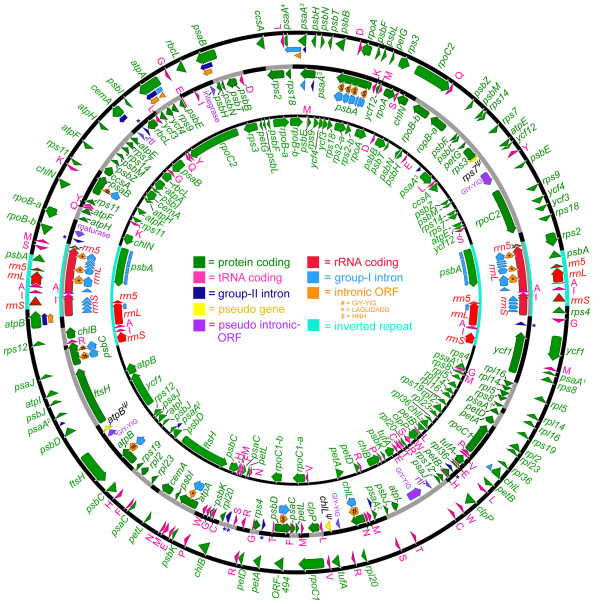
Complete plastid genome maps for Dunaliella salina (middle), Chlamydomonas reinhardtii (inner), and Volvox carteri (outer). The D. salina plastid genome (this study) is 269 kb. The C. reinhardtii and V. carteri plastid genomes (GenBank accession numbers FJ423446 and GU084820) are 204.2 kb and ~525 kb, respectively. Arrows within the coding regions denote transcriptional polarities. Transfer RNA-coding regions are designated by the single-letter abbreviation of the amino acid they specify. Introns within intergenic regions are labeled with blue asterisks. Pseudogenes are labeled with a ψ. For all three genomes, the psaA gene is fragmented; the translational order of these fragments is set out using superscript numbers. The portions of the D. salina genome map that are gray (as opposed to black) highlight gene colinearity (not including introns) with either the C. reinhardtii or V. carteri plastid genomes.